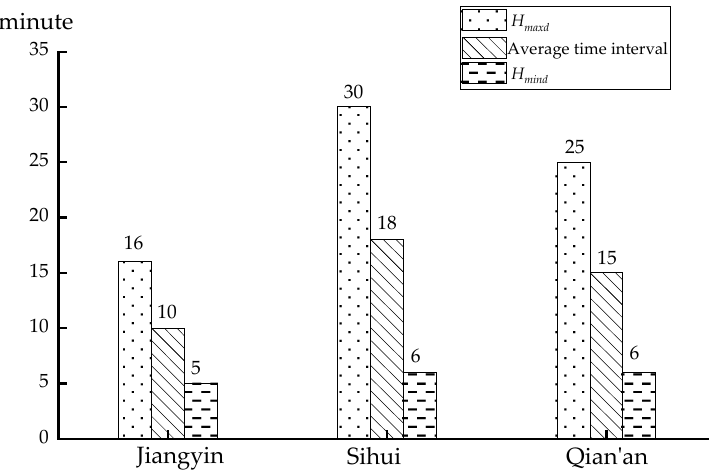
Figure 7. Departure interval of cases.